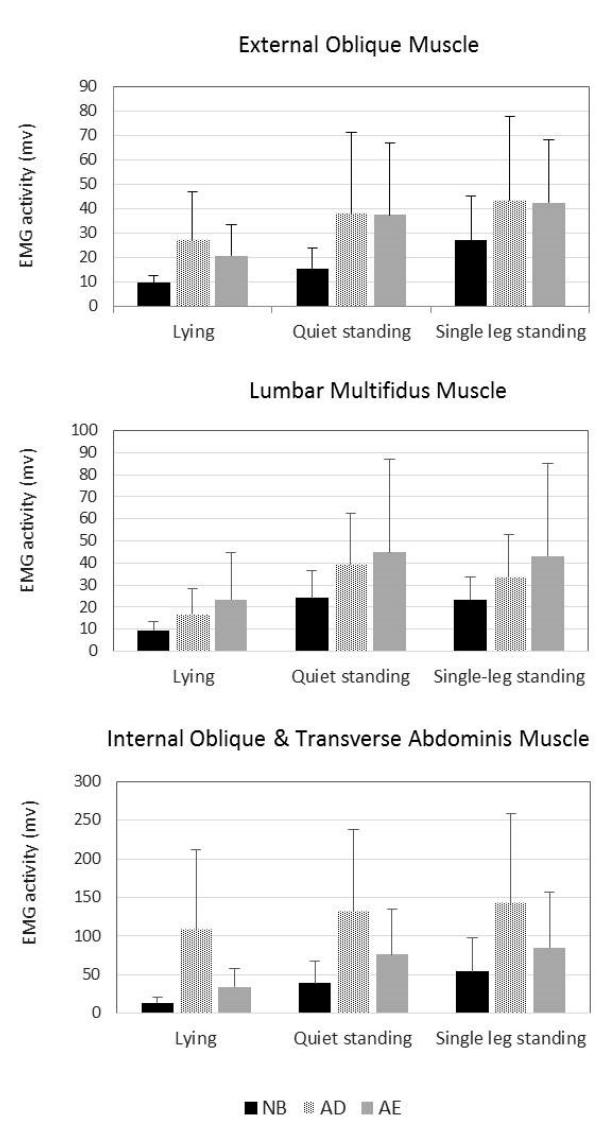
Figure 3. Mean thickness of the lumbar stabilization muscles during natural breathing (NB), ab- dominal drawing-in (AD), and abdominal expansion (AE) strategies in different body positions. Error bars indicate standard deviations.